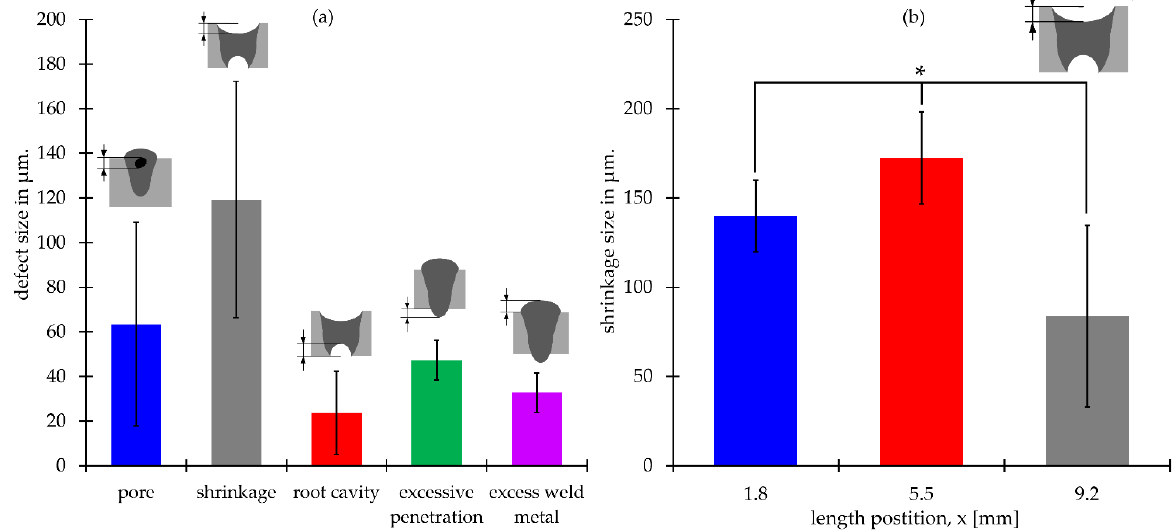
Figure 9. ( a ) Average size of the defects encountered in the micro-spot welds ( b ) measurements of the shrinkage defects in the micro-spot welds. * p - value ≤ 0.0001.